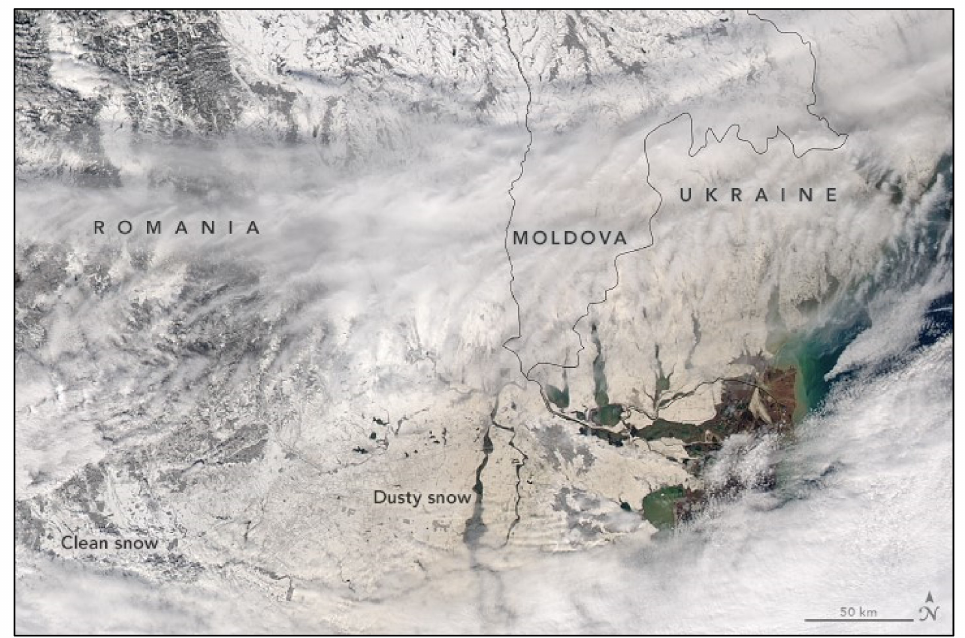
Figure 9. Satellite image from the 24 th of March 2018, indicating the area covered by orange snow extended from the South-East of Romania to the Black Sea over the Ukraine